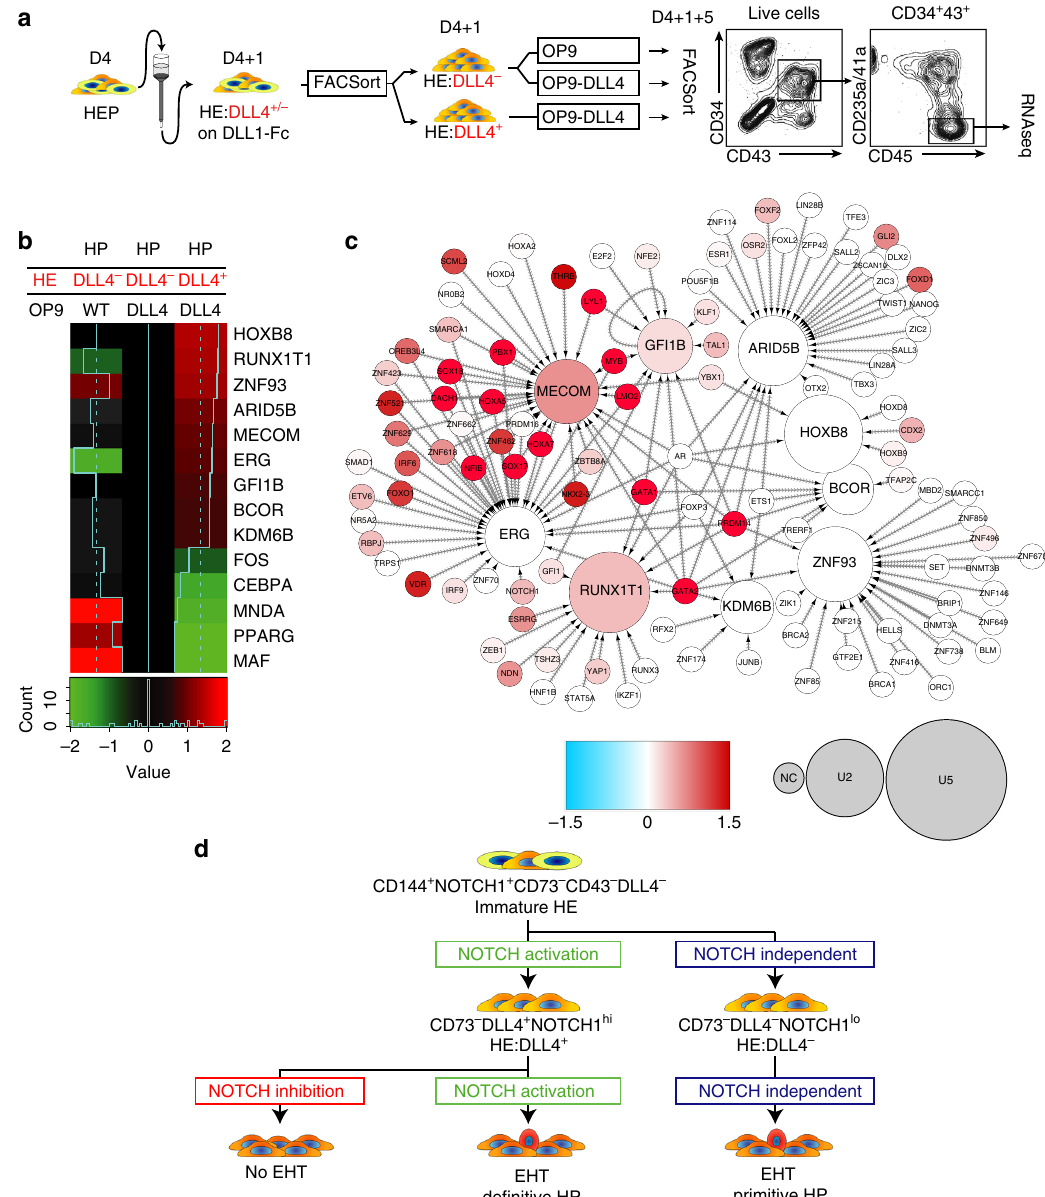
Fig. 6 HPs derived from DLL4 + HE cells activate de fi nitive hematopoietic program. a Experimental strategy for generating and characterizing HE:DLL4 + / − -derived HPs. D4 HE cells where cultured on DLL1-Fc for 24 h, followed by puri fi cation of D4 + 1 HE:DLL4 + and HE:DLL4 − and subsequent culture on OP9 or OP9-DLL4. Five days later (D4 + 1 + 5), CD34 + CD43 + CD45 + CD235a/41a − population was FACSorted from each condition and RNA was extracted for RNA-seq. b A heatmap of differentially expressed transcription factor genes in HPs derived from indicated cell populations. The expression is shown as a log ratio of gene expression relative to HPs generated from HE:DLL4 − cells on OP9-DLL4. c Transcriptional regulatory network reconstructed with the nine transcription factor-encoding genes (the nodes with incoming interactions) differentially expressed in HPs derived from HE:DLL4 + . Size of the nodes represents relative abundance of mRNA of the respective gene, computed as log2(fold change) in DLL4 + vs. DLL4 − (see circle size scale below). Statistically insigni fi cant changes in mRNA abundance (examples: GATA1, GATA2) were set to zero. Upregulation effects are mapped onto the node size as indicated. The color density represents enrichment of known targets of that transcription factor (regulon members) among the differentially expressed genes (see − log10(FDR) color scale below). Network visualization was performed using Cytoscape ver. 3.4.0 74 . d Schematic diagram of NOTCH regulation on HE speci fi cation and EHT. The most immature hPSC-derived CD144 + CD43 − CD73 − HE cells expressing NOTCH1 but lacking arterial and venous identity arise on day 4 of differentiation. NOTCH activation induces speci fi cation of immature HE into DLL4 + arterial-type HE, fi rst detectable on day 5 of differentiation. Hematopoiesis from arterial-type HE:DLL4 + is NOTCH dependent and produces de fi nitive hematopoietic progenitors. Day 4 HE cells that are not DLL4 + by day 5 of differentiation undergo EHT independent of NOTCH activation and produce NOTCH-independent